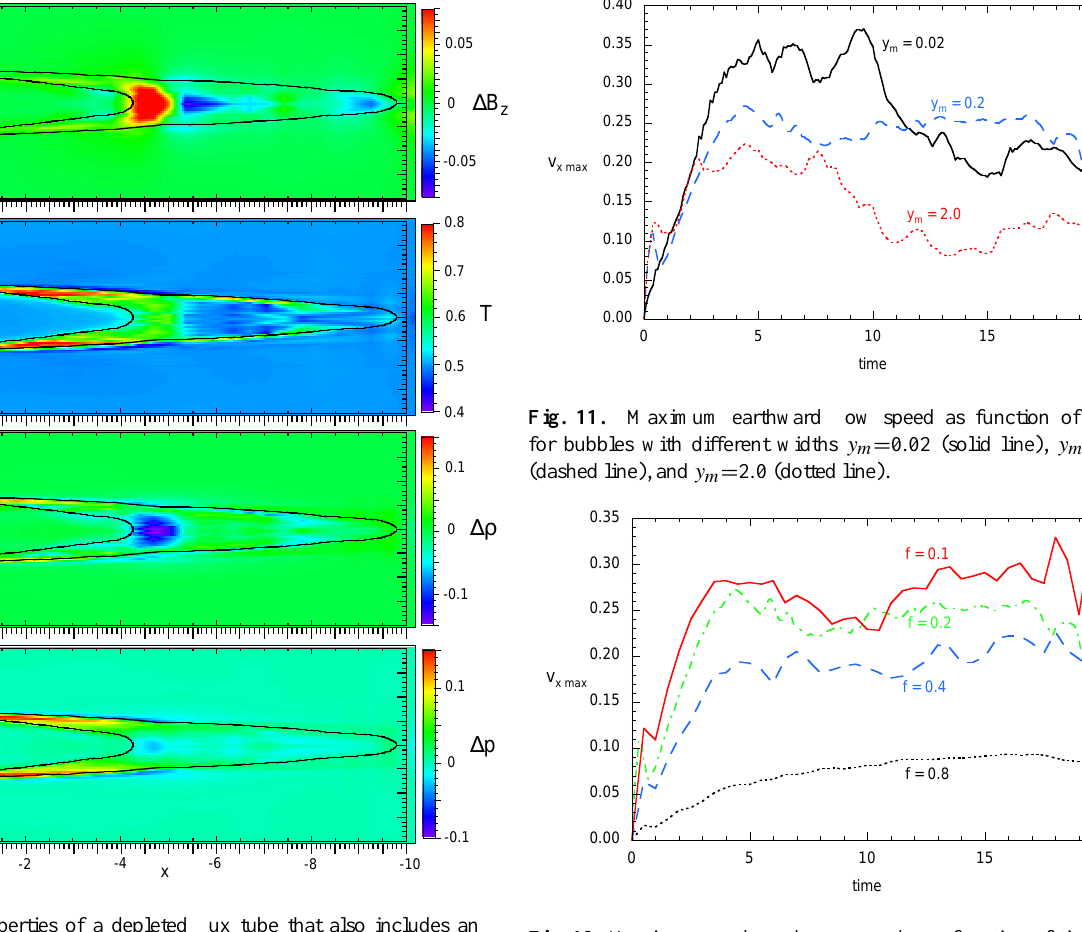
Fig. 12. Maximum earthward flow speed as a function of time for bubbles with y m = 0 . 2 and different amounts of initial pressure re- duction, defined by the factor f (see